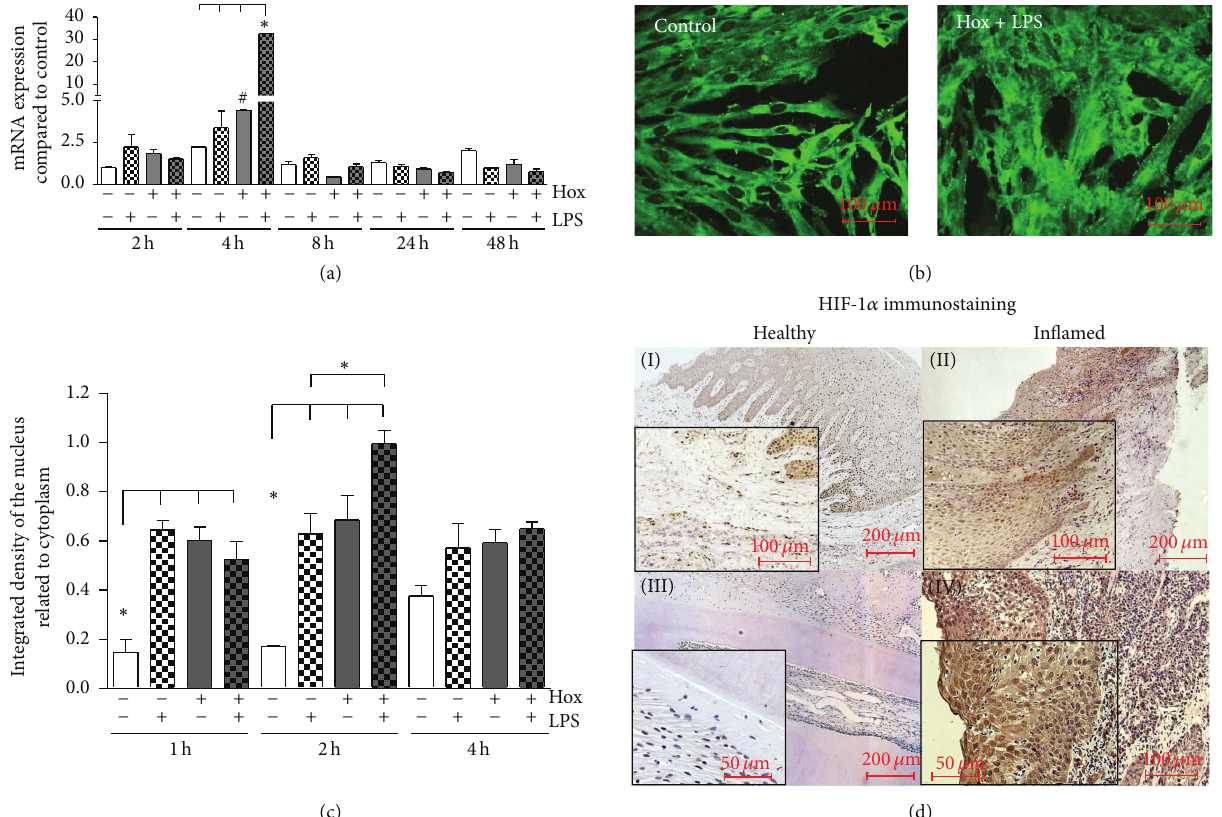
Figure 4: Activation of HIF-1 𝛼 . (a) PDL cells were incubated for the indicated time periods with LPS-PG under normoxic or hypoxic conditions. HIF-1 𝛼 mRNA expression was quantitated by real-time PCR, and expression levels were calculated as n-fold induction of the respective time matched untreated normoxic control. Statistical differences were analyzed by one-way ANOVA followed by different post hoc tests (Dunnett’s and Tukey’s multiple comparison test); # 𝑃 < 0.05 depicts a significant difference with respect to time-matched control, ∗ 𝑃 < 0.05 indicates a significant difference between groups (means ± SD; 𝑛 = 6 ). (b) PDL cells were cultured under normoxic (control)orhypoxicconditions(Hox)andstimulatedwithLPS-PG(1 𝜇 g/mL).HIF-1 𝛼 proteinwasvisualizedbyimmunofluorescencestaining. Representative pictures of cells under normoxic control conditions and after a 2-hour LPS-PG treatment under hypoxic conditions are shown. The scale bars indicate 100 𝜇 m. (c) PDL cells were incubated for 1, 2, and 4 hours. HIF-1 𝛼 protein was detected by immunofluorescence. Density of nuclear HIF-1 𝛼 staining was determined as in relation to total cell area using the freely available image-processing software ImageJ 1.43 (http://rsb.info.nih.gov/ij). Statistical analysis of the processed data were performed by one-way ANOVA followed by Tukey’s multiple comparison test; ∗ 𝑃 < 0.05 indicates a significant difference between groups (means ± SD; 𝑛 = 6 ). (d) Tissue samples from healthy gingiva (I), gingivitis (II), healthy periodontal ligament (III), and periodontitis (IV) were obtained after approval of the Ethics Committee of the University of Bonn and parental as well as patients’ written consent ( 𝑛 = 3 ). Polyclonal primary antibody raised against HIF-1 was used in a concentration of 1:100 for immunohistochemistry. We observed an increase of HIF-1 𝛼 immunostaining in accordance to the progression of periodontal inflammation. The scale bars indicate 50, 100, or 200 𝜇 m in dependence of the